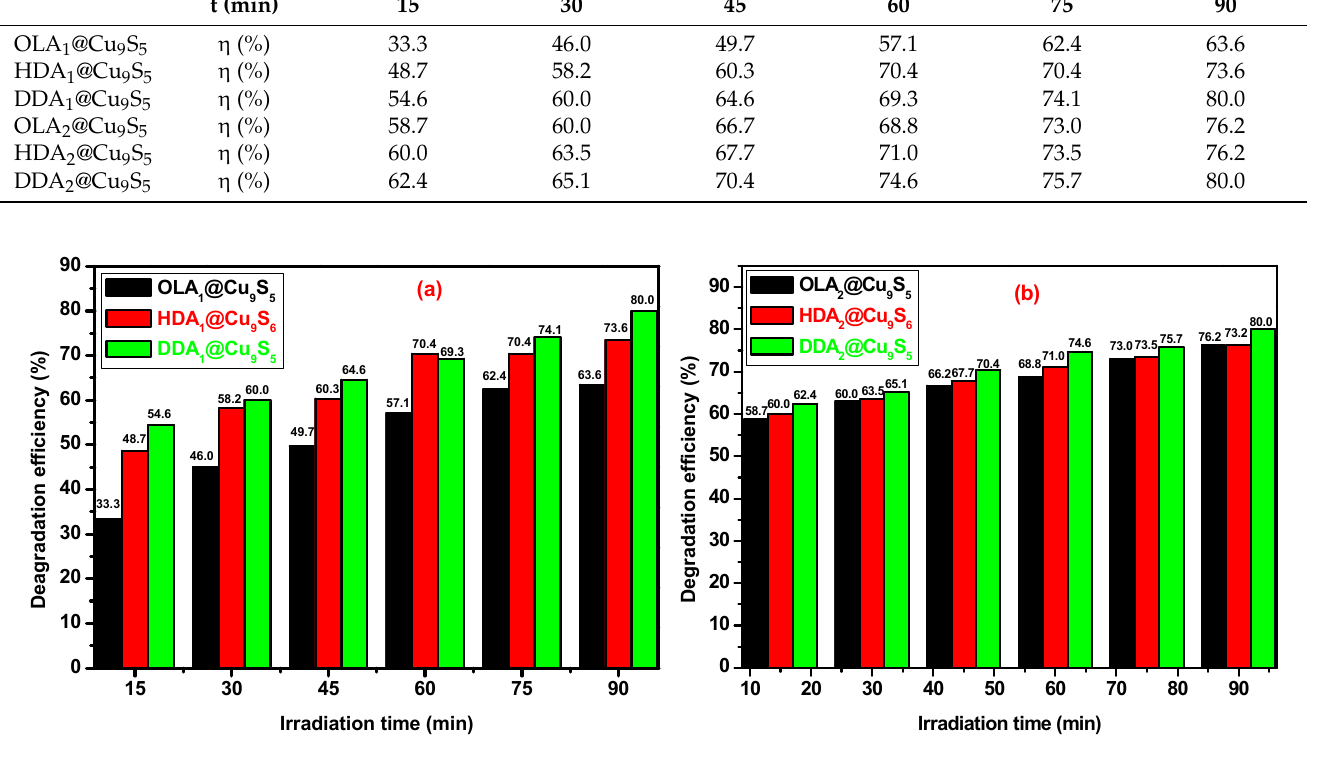
Figure 11. Histograms of degradation efficiencies of MB at different irradiation times using ( a ) complex 1 and ( b ) complex 2 at 190 °C.